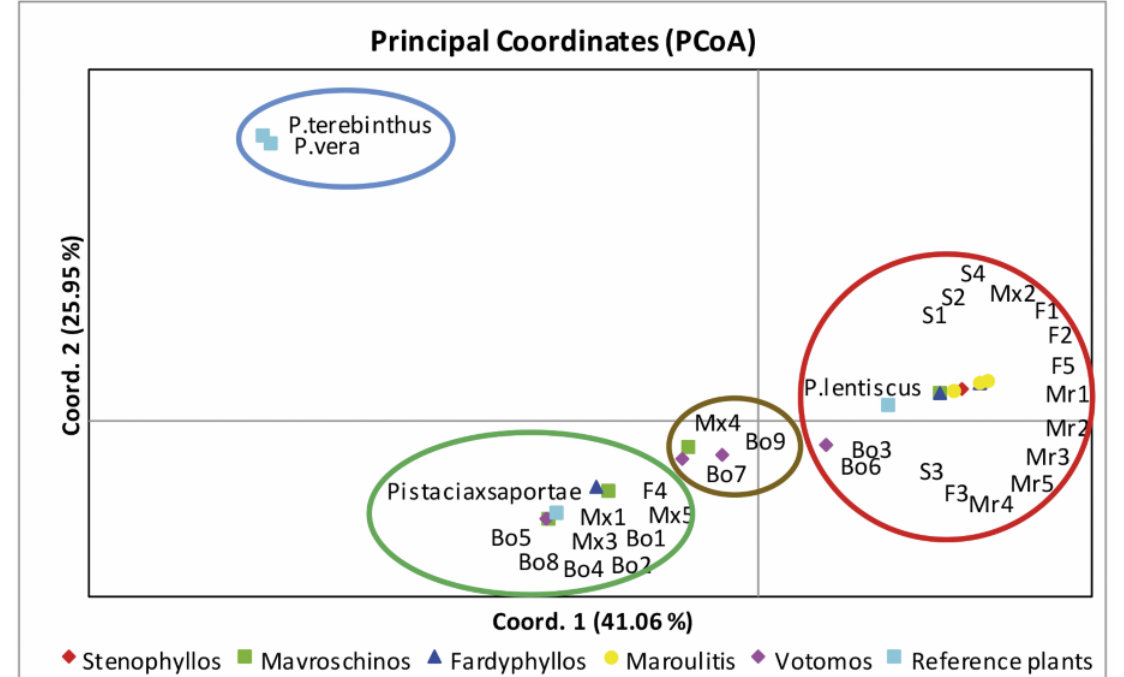
Figure 6 Principal coordinates analysis (PCoA) of 28 individuals in five phenotypes of P. lentiscus based on ITS1 and ITS2 data, compared on four indicator plants. 67.01 of total variance accumulated on the first two components (Coord. 1 = 41.06%; Coord. 2 = 25.95%).